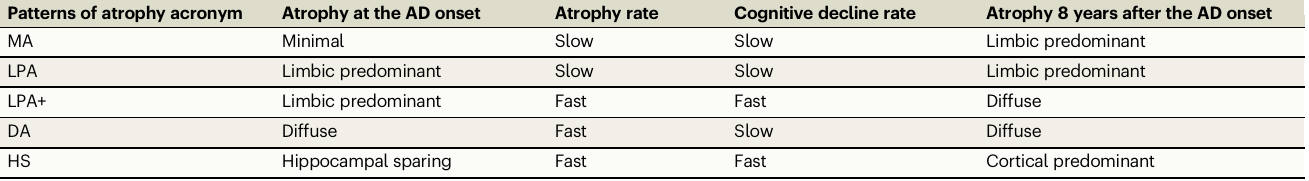
Table 2 | Cluster/cognitive pro fi les summary Patterns of atrophy